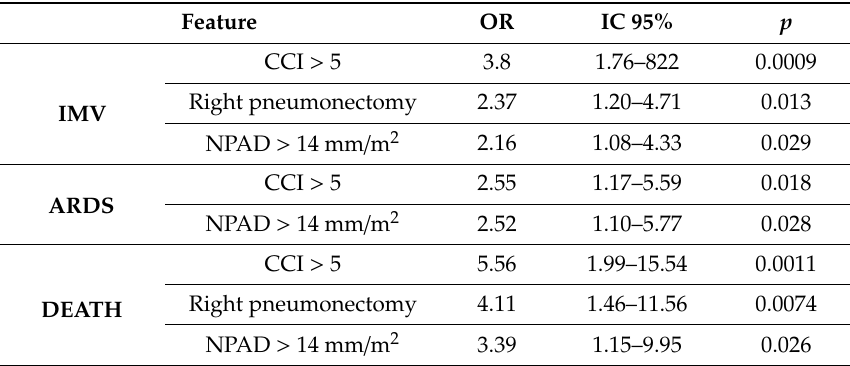
Table 5. Multivariable